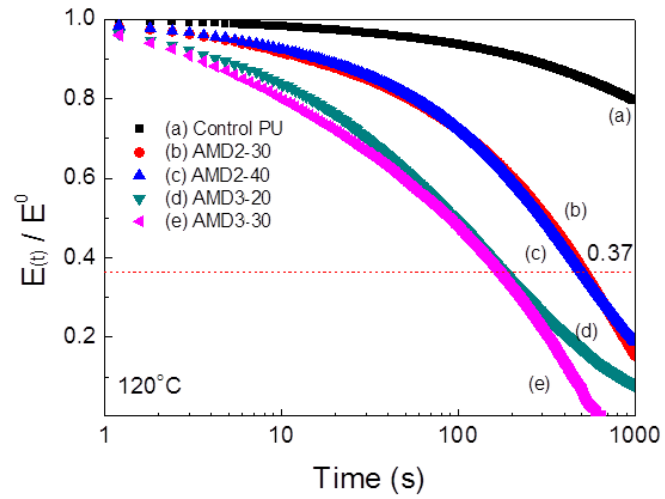
Figure 5. Typical normalized stress relaxation behaviors of AMD-based PUEs.